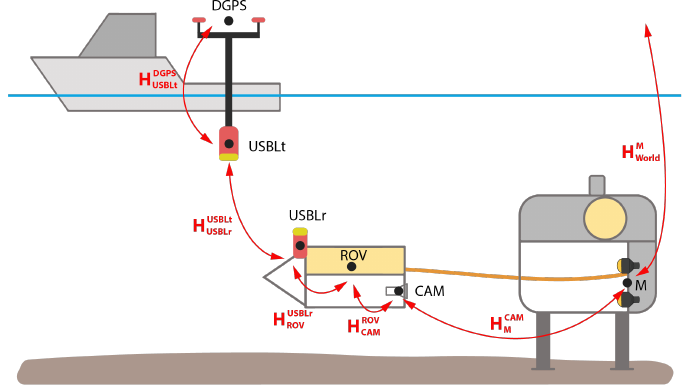
Figure 6. Homogeneous transformations between ship, ROV, TMS and world coordinate frames.